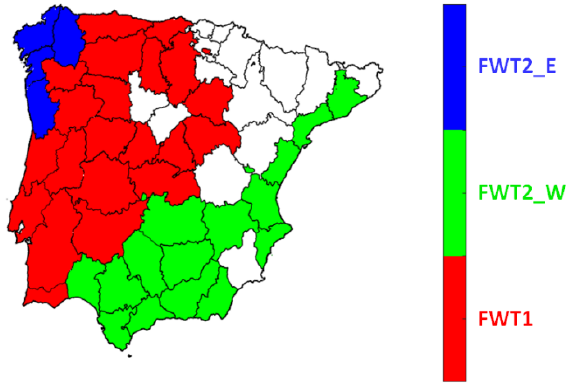
Figure 6. Representation of the predominant fire weather types in each province. Fire weather type 1 (FWT1) is represented in red in provinces where temperature and relative humidity dominate. FWT2 (fire weather type 2) is represented in blue, FWT2_E (fire weather type 2_east), and green, FWT2_W (fire weather type 2_west), in provinces where the east or west zonal wind controls large fires activity, respectively. Provinces with very few large fires are represented in white and were disregarded.